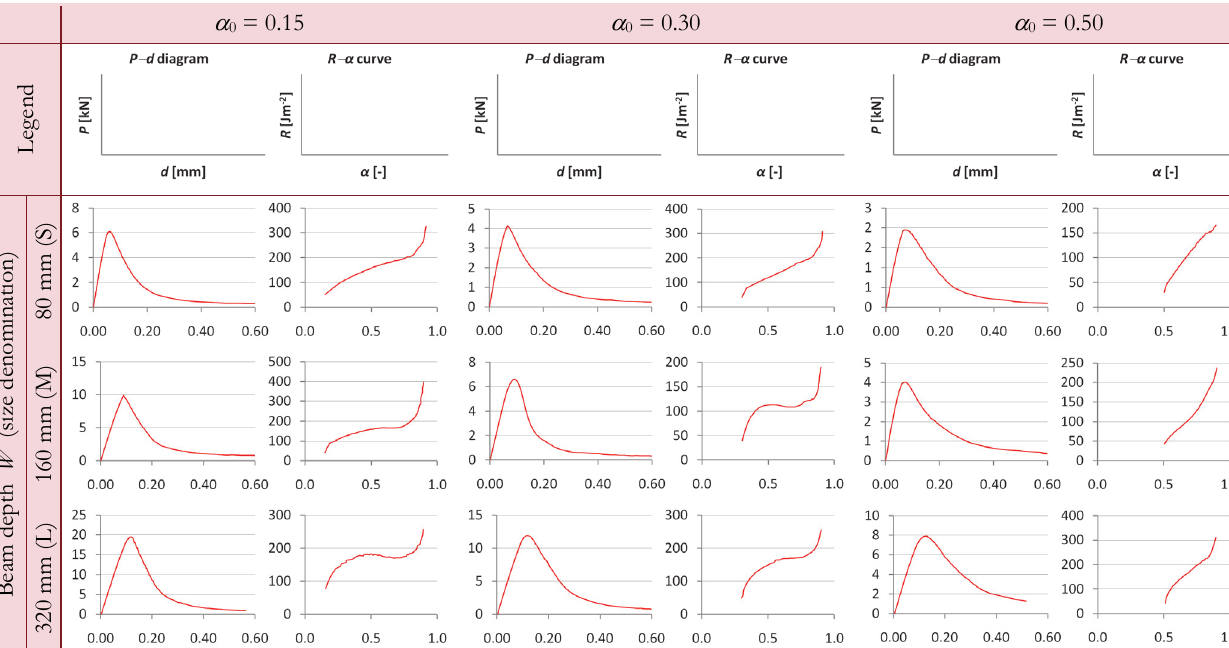
Figure 6: Simulated P – d diagrams and corresponding R –  curves for each specimen size W and relative notch length  0